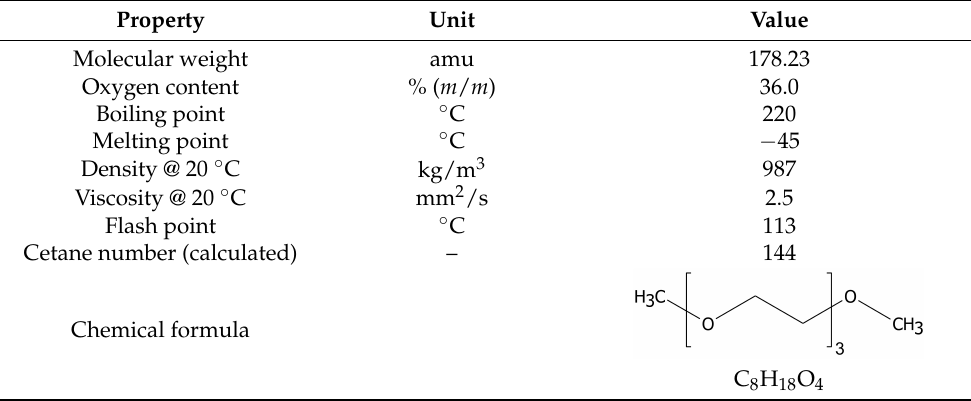
Table 1. Some properties of triethylene glycol dimethyl ether (triglyme, TEGDME).